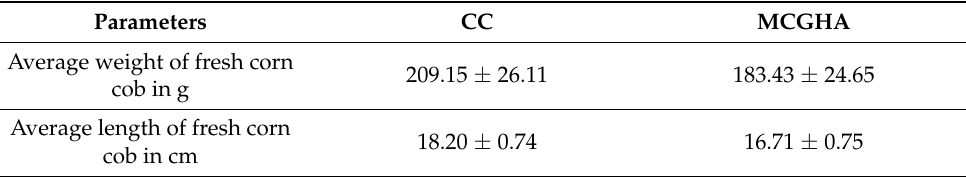
Table 2. Average weight and length of corn cobs obtained at harvesting time.